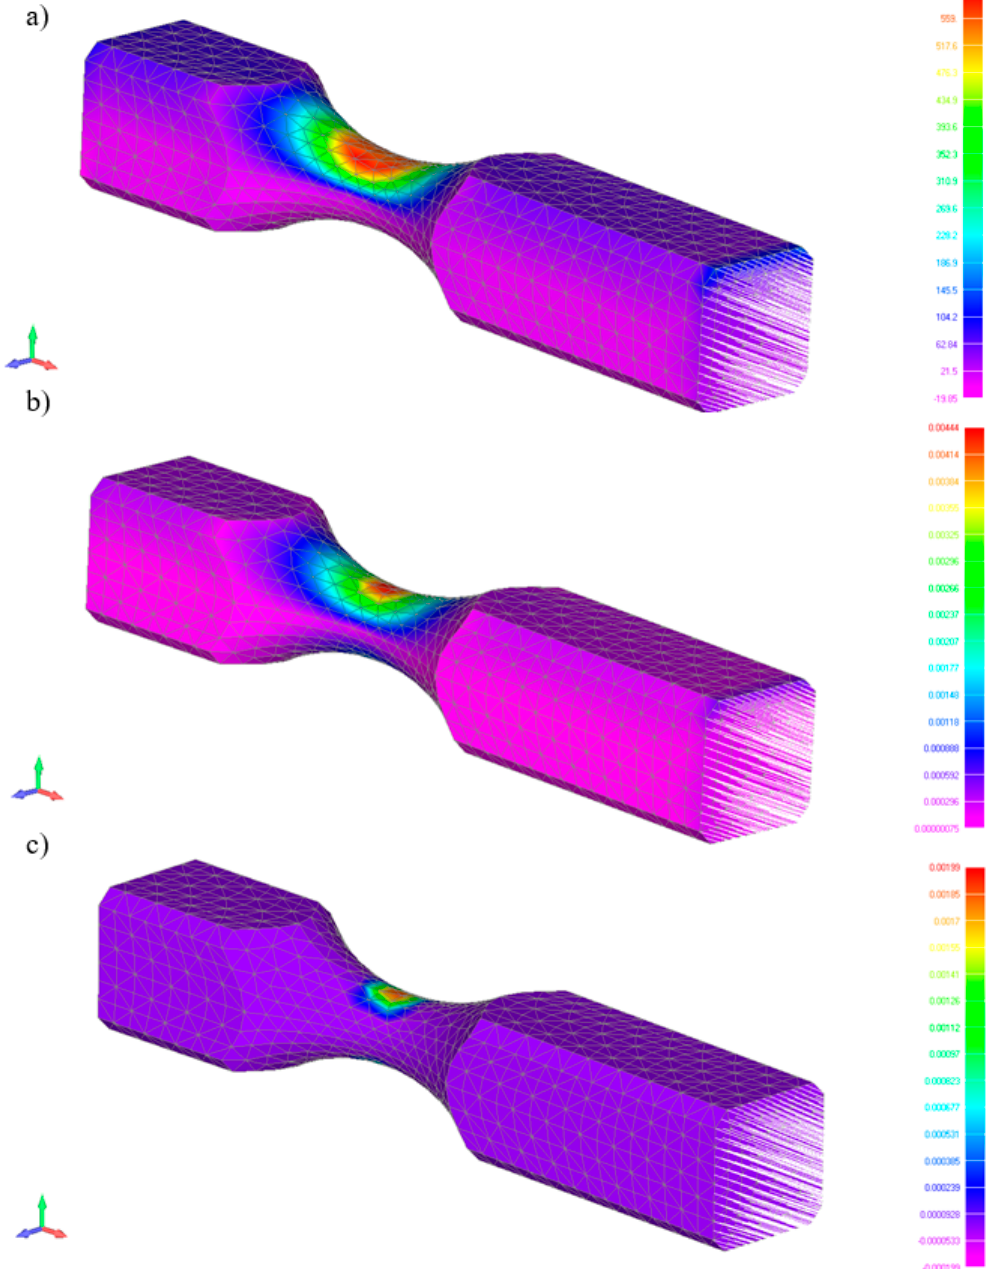
Figure 7. Calculations: maximum stress ( a ), maximum deformation ( b ), and maximum plastic deformation for specimen ( c ).